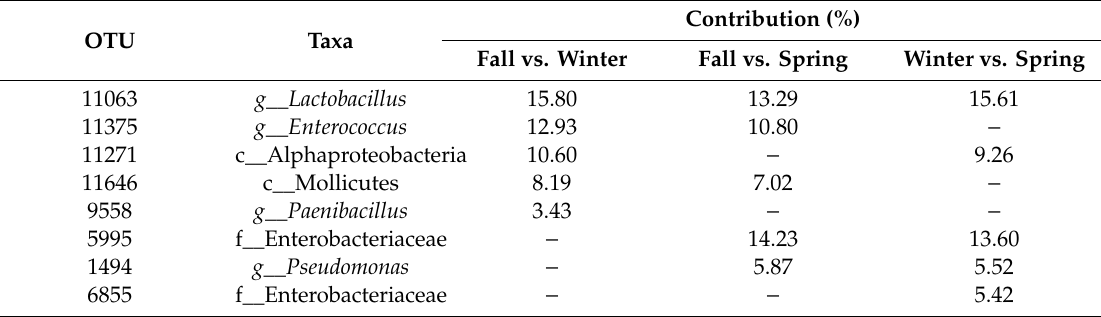
Table 2. SIMPER analysis showing the contribution of bacterial OTU to the di ff erences between seasons. Taxonomic abbreviations: c, class; f, family; g,